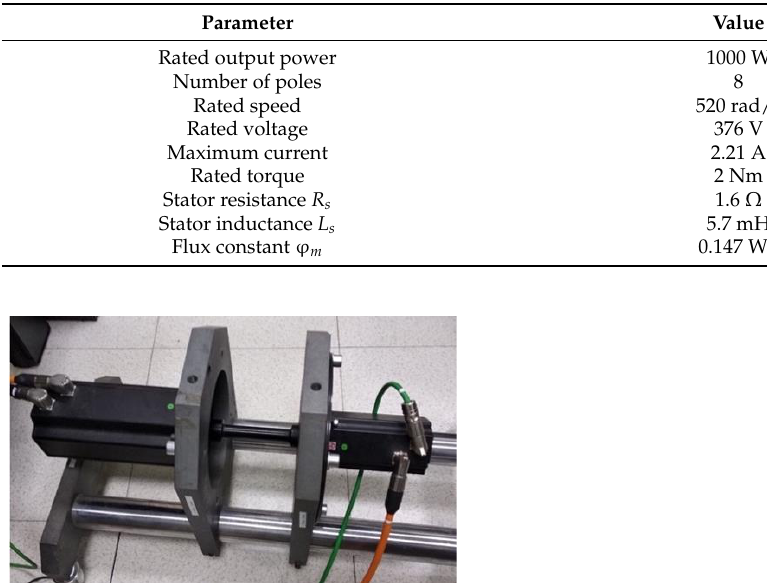
Table 1. Parameters of the SPMSM on which the algorithms were tested.